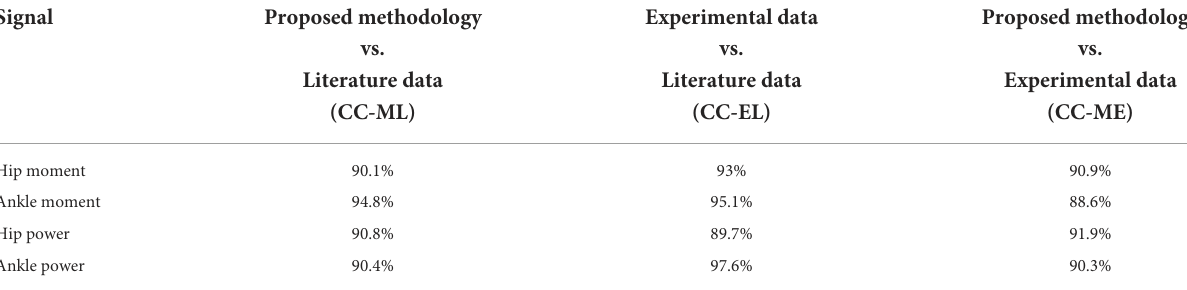
TABLE 1 Correlation coefficient of the hip and ankle moments and powers.